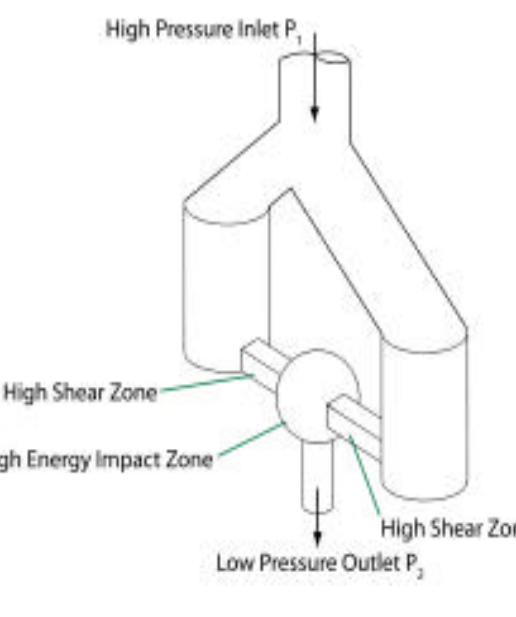
Figure 4. Y-type interaction